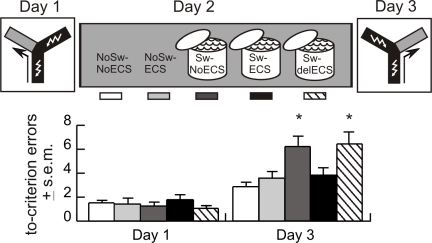
Experiment 4—Electroconvulsive shock blocked the swim-induced enhancement of memory.All rats were trained in the intensive training protocol on Day 1. On Day 2, ECS was delivered immediately after the swim in the Sw-ECS group (black, n = 16), 5 h after the swim in the Sw-del-ECS group (diagonal stripes, n = 13) or without the forced swim experience in the NoSw-ECS group (light gray, n = 11). Rats in the NoSw-NoECS group were only handled (white, n = 11) and animals from the Sw-NoECS group (medium gray, n = 12) only swam. On Day 3, the rats were tested in the reversal paradigm. The average number of to-criterion (4/4) errors on Days 1 and 3 are plotted. The groups did not differ on Day 1, but they differed on Day 3 (F4,58 = 4.5, p = 0.003). The Sw-NoECS and Sw-delECS animals expressed stronger memory during the reversal test in comparison to all other groups (all ps <0.05). Performance of the NoSw-ECS, Sw-ECS, and the NoSw-NoECS groups was not different (p>0.05) (* p<0.05).